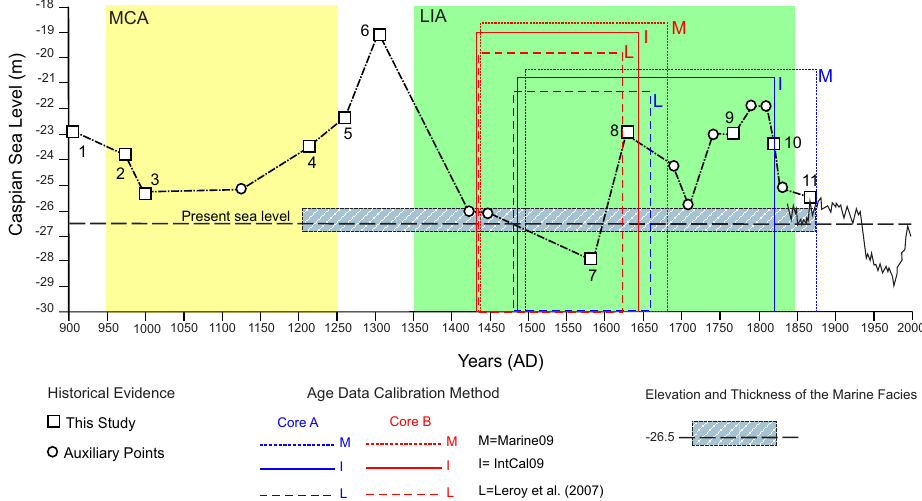
Fig. 9. Caspian sea-level curve for the last millennium based on historical evidence from this study (squares) and other researchers (Br¨uckner, 1890; Varushchenko et al., 1987; Karpychev, 1998, 2001) denoted as circles. Numbers for the squares show the correspondent number of eleven historical reports in Table 7. The blue and red rectangles correspond to samples A and B, respectively (Table 2). Quadrangles with letters M, I and L are the ages of dated horizons in this study based on different calibration methods. M: Calibrated ages based on Marine09 curve with 1 R = 26 ± 69 (Kuzmin et al., 2007; Olsson, 1980). I: Calibrated ages based on IntCal09 curve and RE = 407 ± 27 (Kuzmin et al., 2007; Olsson, 1980). L: Calibrated ages based on IntCal09 curve and RE = 383 (Leroy et al., 2007). The widths of blue and red rectangles correspond to age ranges (Table 2) and the heights were chosen differently to clearly distinguish the rectangles. The coloured boxes show the Medieval Climate Anomaly (MCA) and the Little Ice Age (LIA). The horizontal dashed box shows the thickness of the oldest marine facies in this study (Fig. 4) for the same altitude and time range. The present Caspian sea level is shown as a dashed horizontal